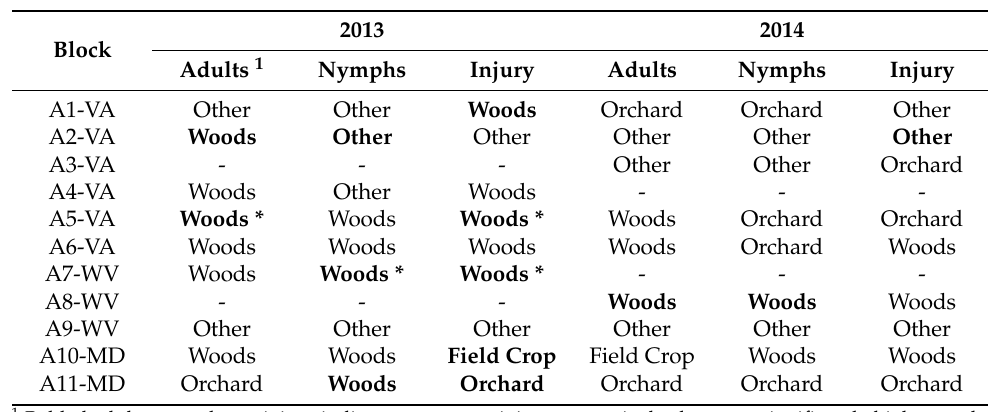
Table 6. Qualitative comparisons of H. halys adult and nymph captures and fruit injury at harvest by orchard border habitat in apple blocks in the Mid-Atlantic, USA, in 2013 and